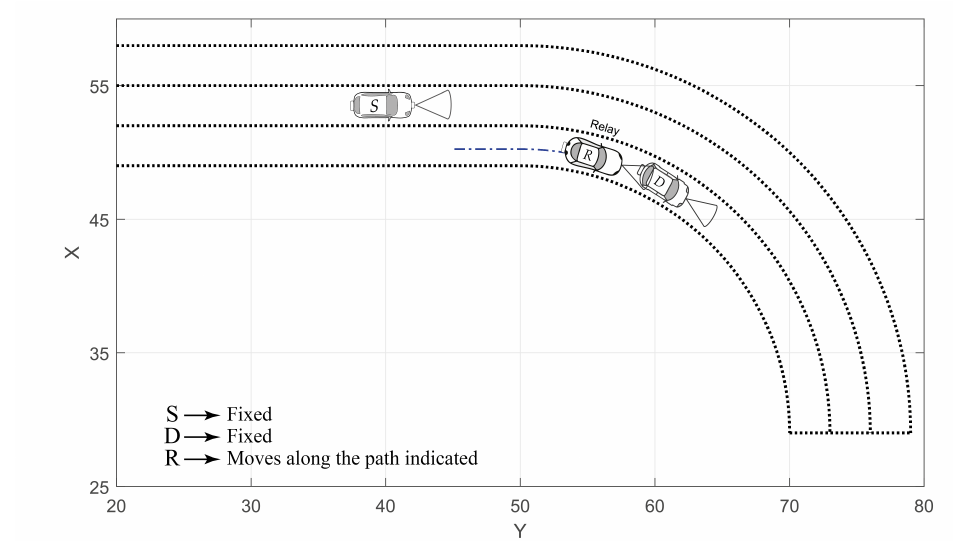
Figure 4. Schematic of the cooperative communication along a curvilinear roadway. D is considered fixed at different angular positions, while R follows the dash-dotted path between S and D . For all cases S is considered as having y s < 50